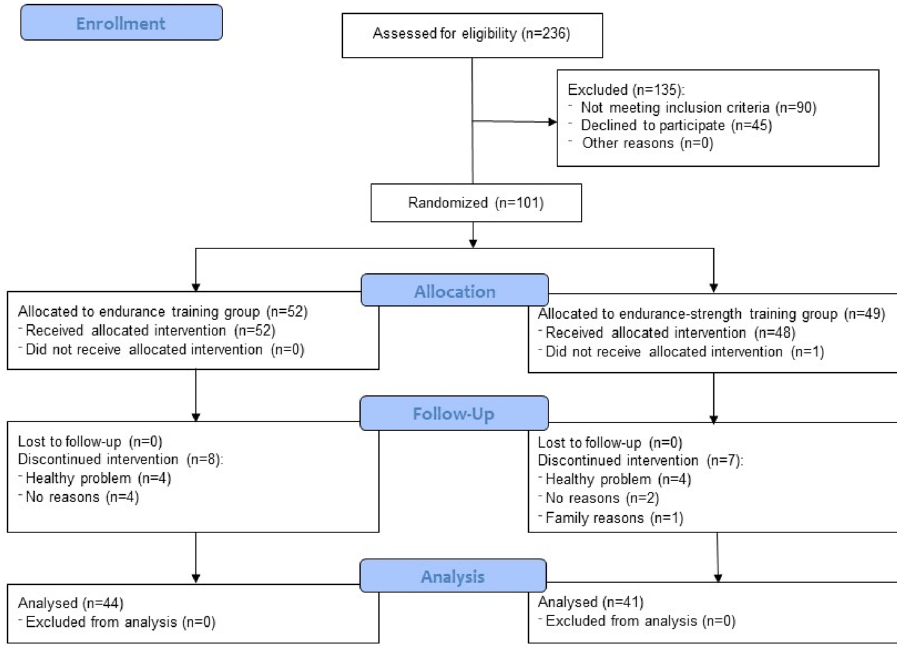
Figure 1. CONSORT 2010 flow diagram 83 . The Figure was previously published in the Journal of Clinical Medicine which publishes articles under an open access Creative Common CC BY